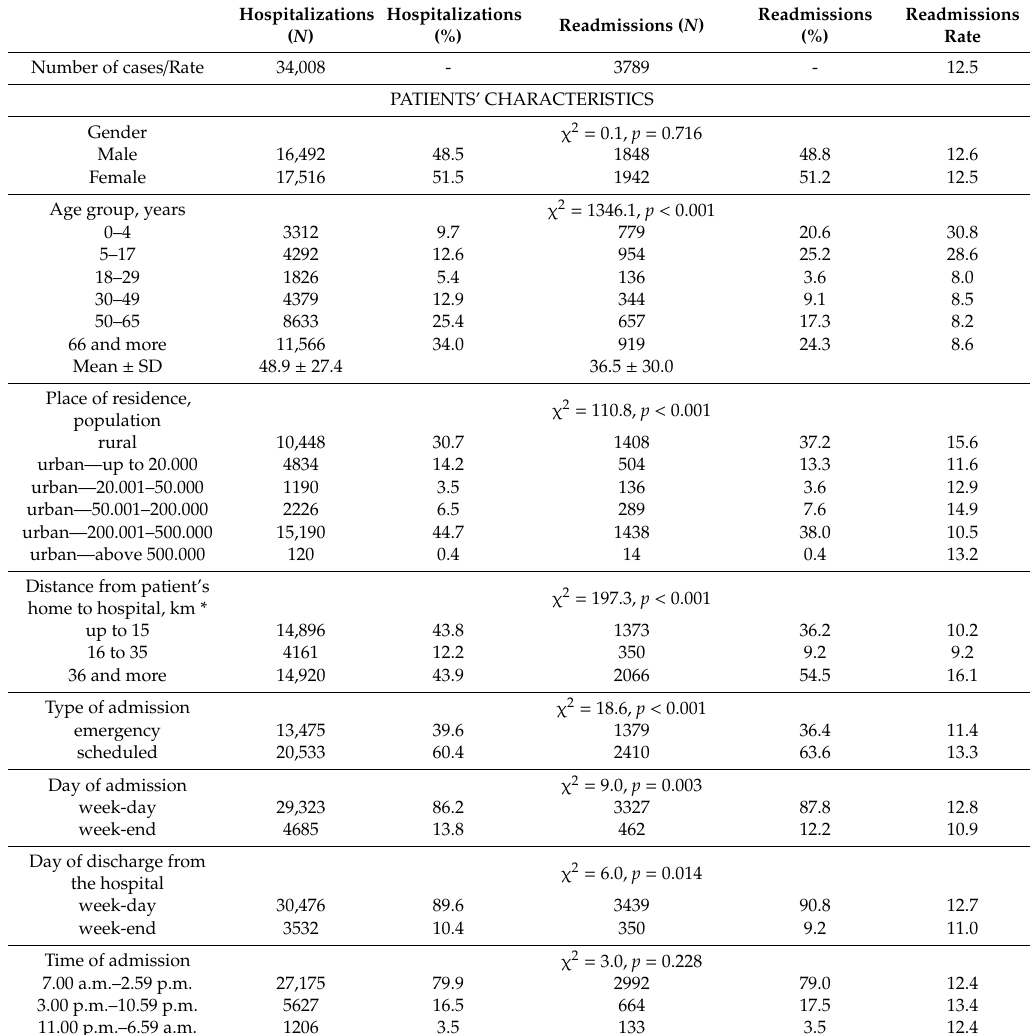
Table 1. Selected characteristics of patients and hospital